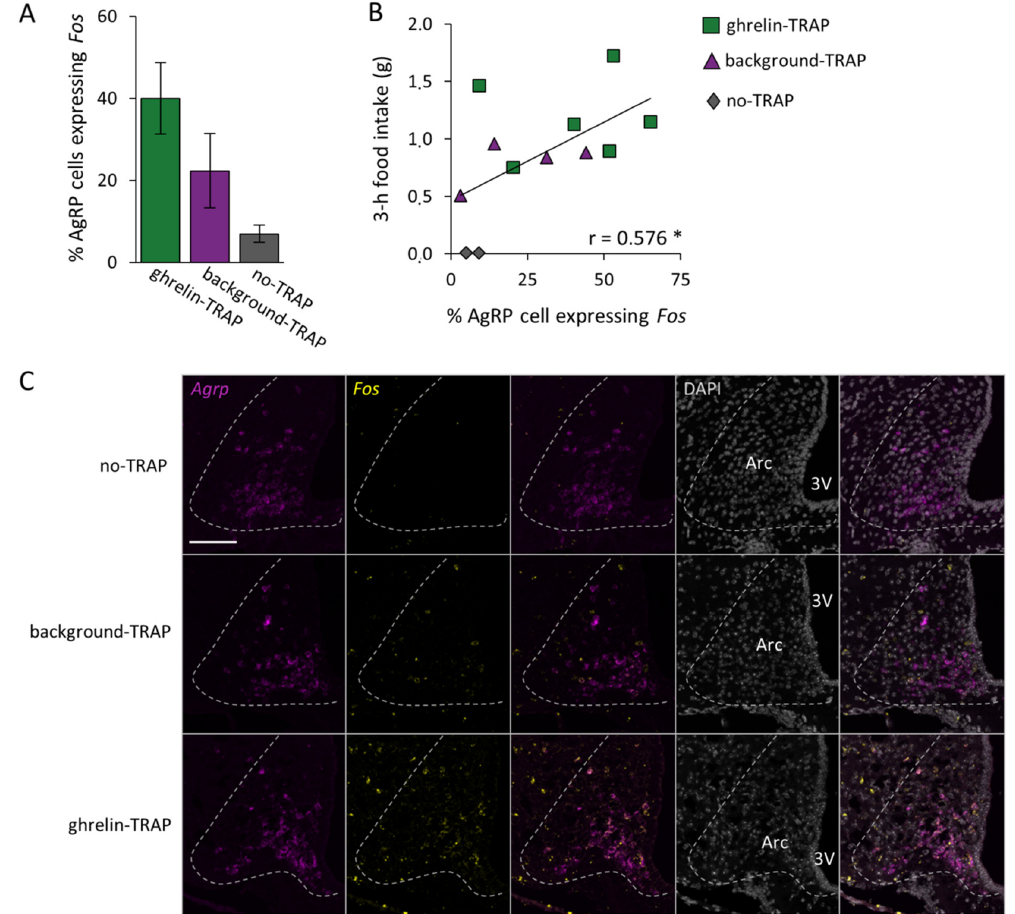
Figure 4. The level of AgRP activation correlates with food intake. Fluorescence in situ hybridization through RNAscope for Agrp and Fos was performed on arcuate nucleus (Arc)-containing brain sections of ghrelin-TRAPed (n = 6), background-TRAPed (n = 4), and no-TRAP (n = 2) mice that received clozapine-N-oxide (CNO) before sacrifice. ( A ) The percentage of Agrp -expressing cells that co-express Fos in the Arc in the three experimental groups. Error bars represent ± SEM; ( B ) The 3 h food intake time point upon CNO administration shown in relationship to the percentage of AgRP cells expressing Fos . The asterisk (*) indicates a significant Pearson correlation coefficient: p = 0.050; ( C ) Representative fluorescence images of RNAscope for Agrp and Fos , performed on no-TRAP, background-TRAPed, and ghrelin-TRAPed mice. Agrp is shown in magenta, Fos in yellow and DAPI nuclear (background) staining in gray. Scale bar: 100 µm, applicable to all 15 panels. Third ventricle: 3V.